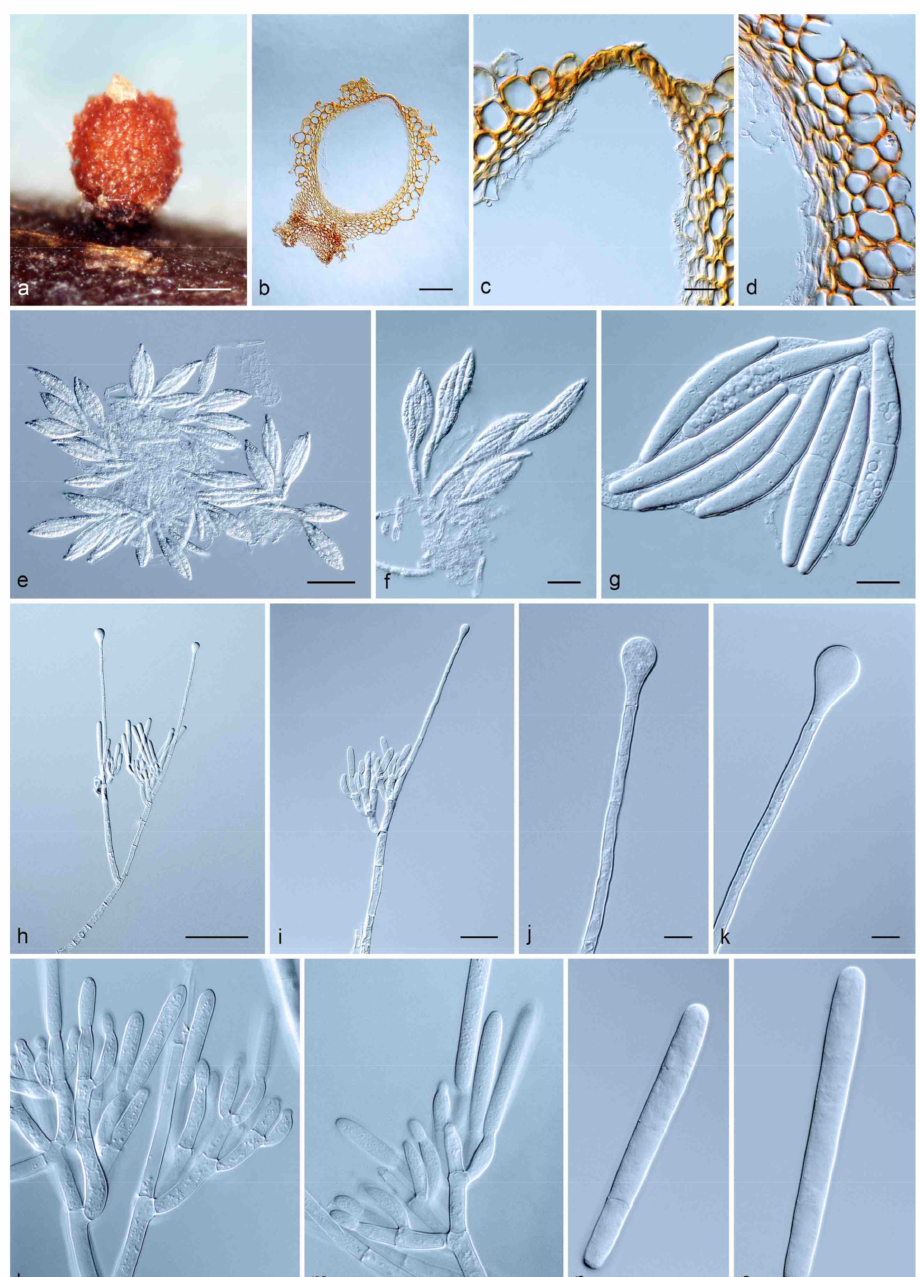
Figure A9. Calonectria ilicicola . ( a ). Perithecium; ( b ). vertical section through a perithecium; ( c ). cells around ostiolar region of perithecium; ( d ). section through lateral perithecial wall; ( e , f ). asci; ( g ). ascospores; ( h , i ). macroconidiophore; ( j , k ). ovoid to sphaeropedunculate vesicles; ( l , m ). coni- diogenous apparatus with conidiophore branches and elongate doliiform to reniform phialides; ( n , o ). macroconidia.—Scale bars: a = 200 µ m; b = 100 µ m; c, d, f and i = 20 µ m; e and h = 50 µ m; g and l–o = 10 µ m; j, k = 5 µ